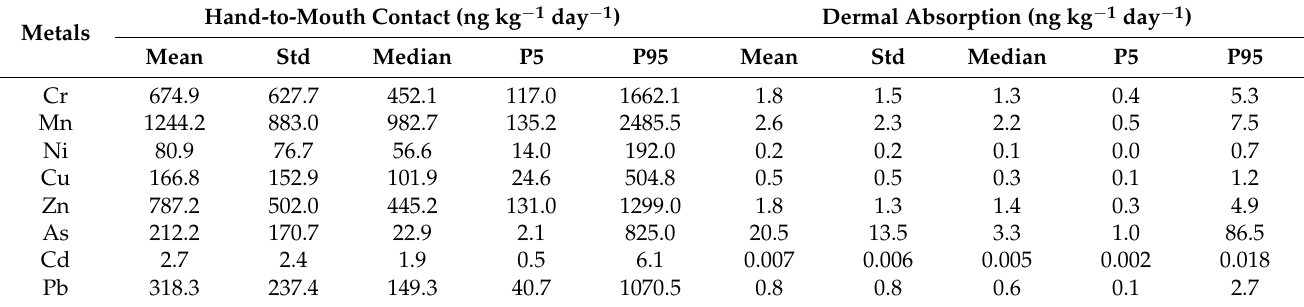
Table 4. The estimated exposure dose to metals in hand wipes through hand-to-mouth contact and dermal absorption